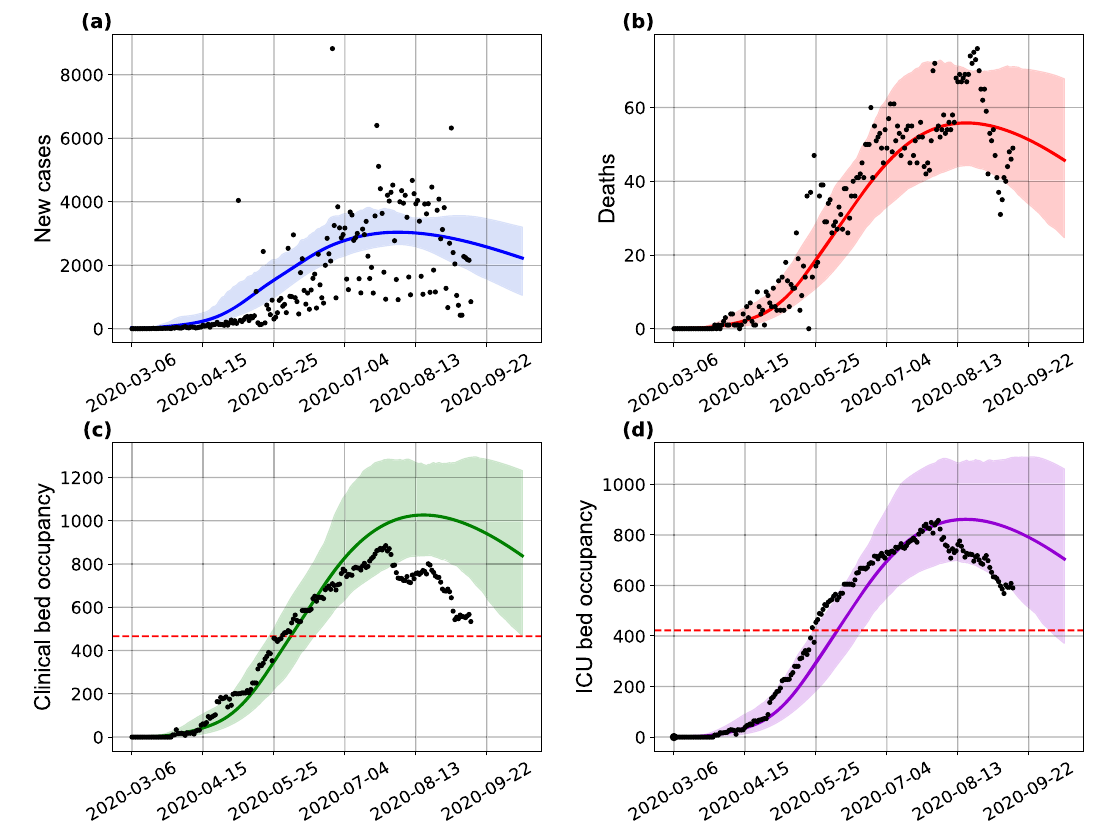
Fig. 7 COVID-19 dynamics in Bahia. Projection of the ( a ) number of cases, ( b ) deaths, ( c ) clinical hospitalization, and ( d ) ICU bed requirements with a changing transmission rate in Bahia up to September 13, 2020. The horizontal red dashed lines in plots c – d , are, respectively, the number of beds for clinical hospitalization (466 beds) and ICUs (422 beds) available on May 4, 2020. The shaded error bands represent 95% con fi dence intervals of the mean calculated using the weighted non-parametric bootstrap method. The assumed parameter values are shown in Supplementary Table 4. Raw data